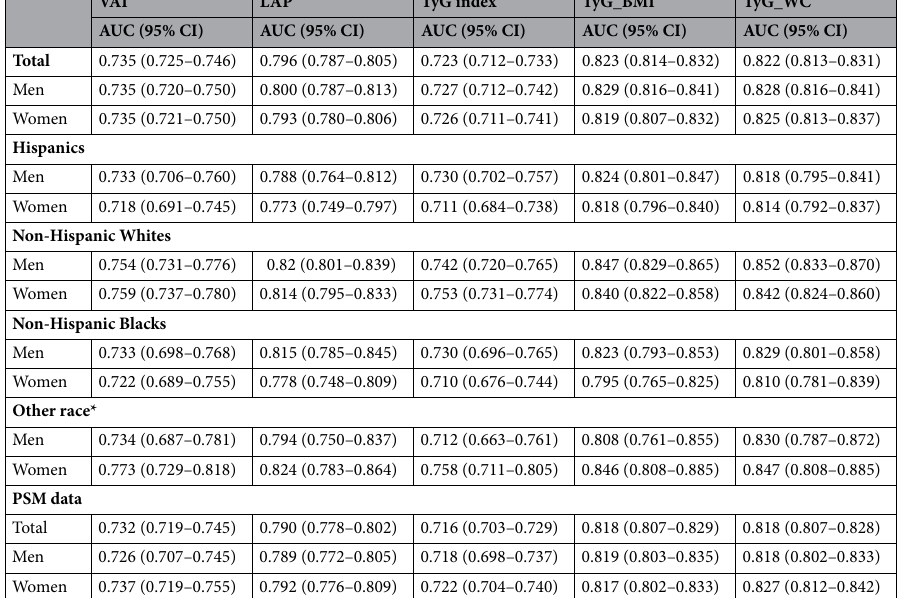
Table 3. Area under the curve for each parameter for insulin resistance according to race/ethnicity and sex. HOMA-IR homeostasis model assessment-insulin resistance, VAI visceral adiposity index, LAP lipid accumulation product, TyG index triglycerides and glucose index, BMI body mass index, WC waist circumference, AUC area under the curve, PSM propensity score matching with age, sex, and race/ethnicity. *Other race included non-Hispanic Asian and multi-racial